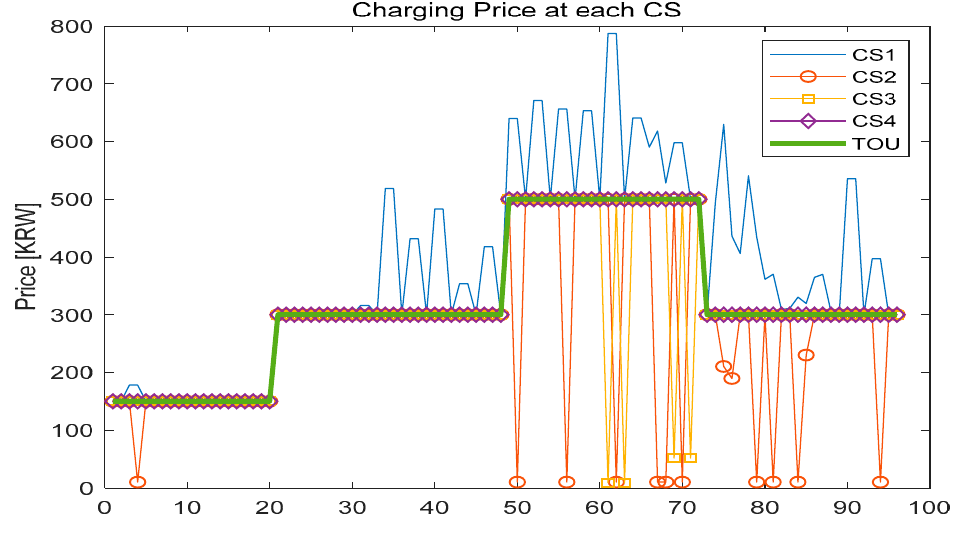
Figure 18. Charging price of CSs in Case 4. Table 5. Summary of Simulation Results in Case 4.